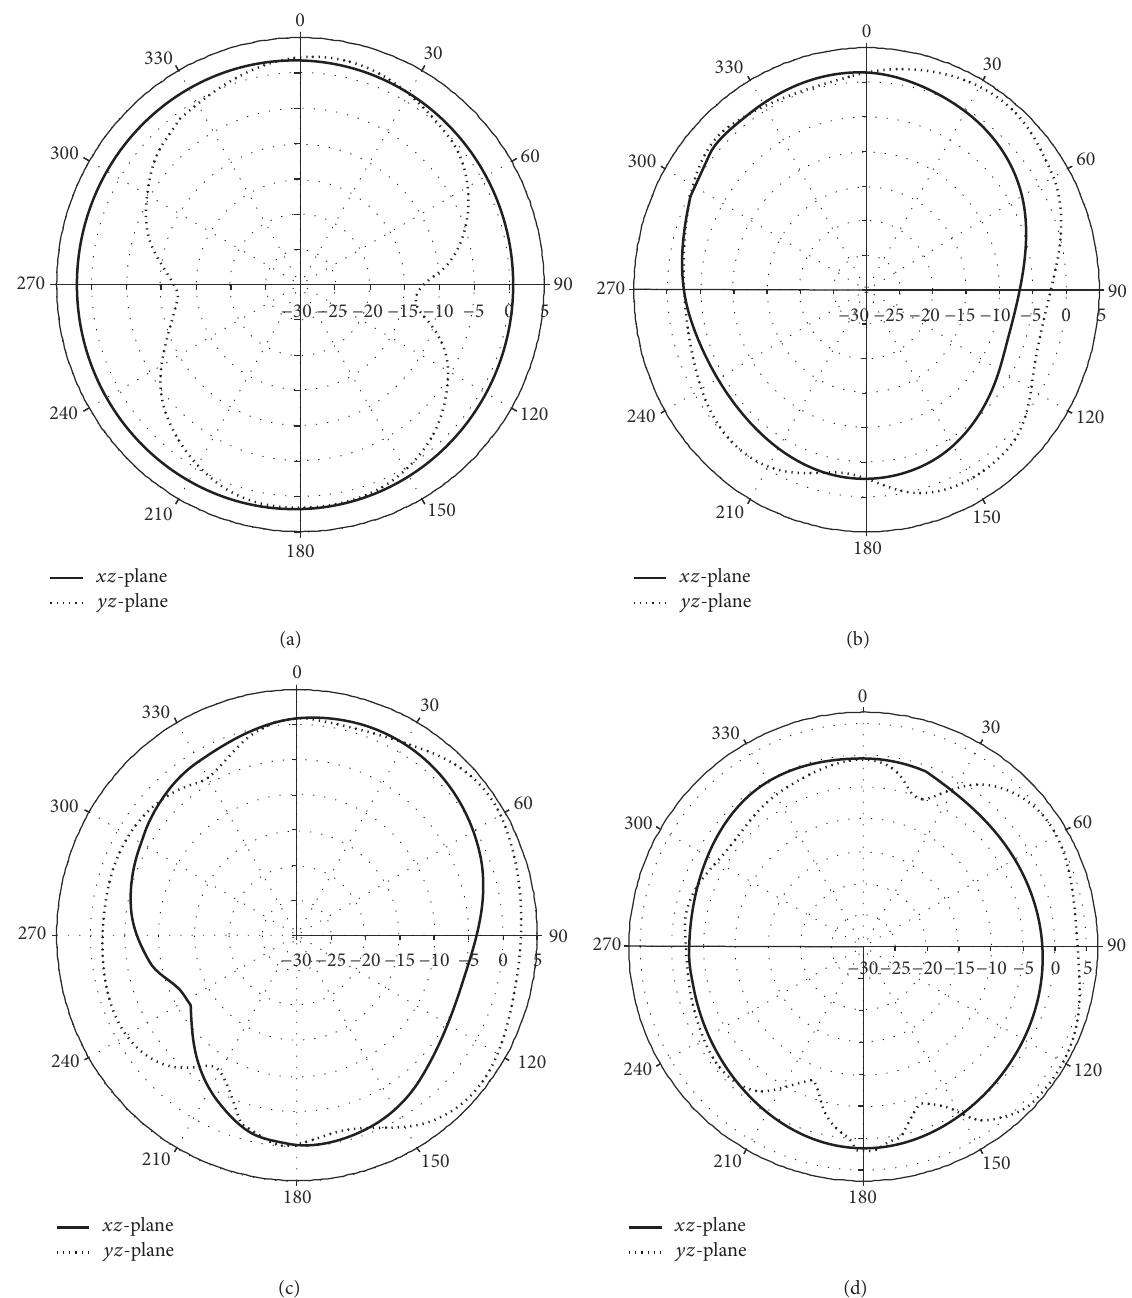
Figure 8: Radiation patterns of the proposed PIFA: (a) at 790 MHz, (b) at 1870 MHz, (c) at 2550 MHz, and (d) at 3400 MHz.